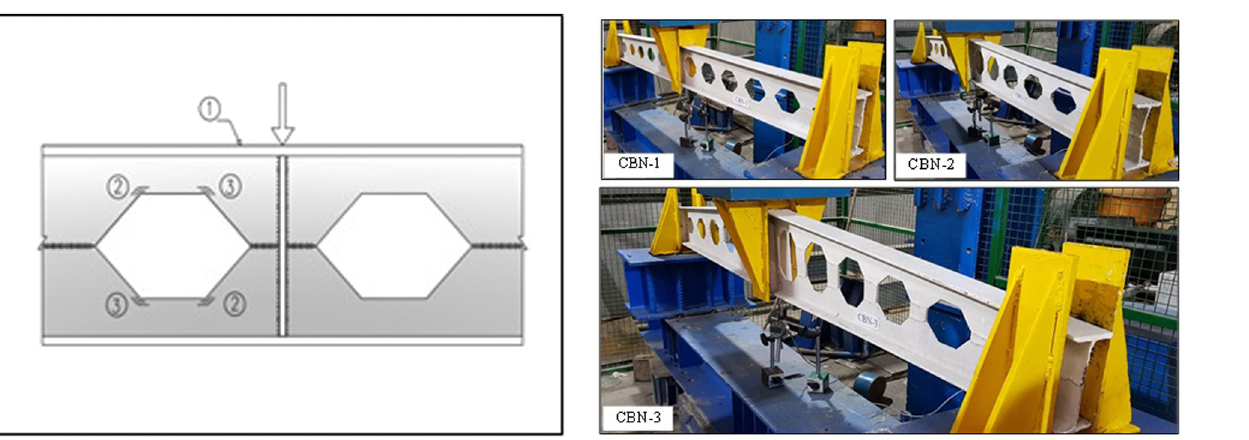
Figure 12: Test setup of TCBs ( CBN - 1, CBN - 2 and CBN - 3 )